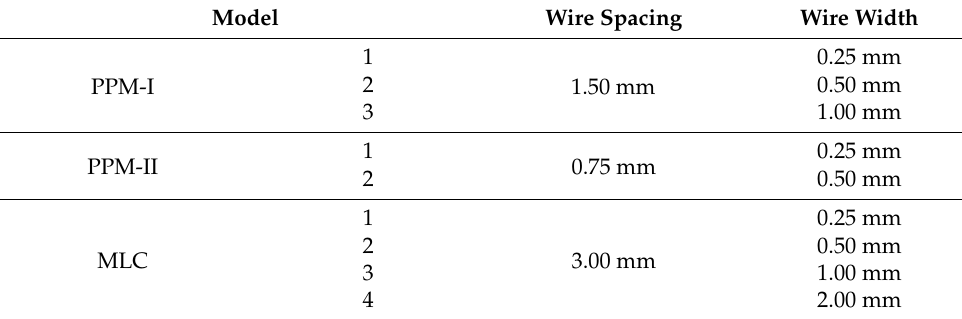
Figure 19. Structure diagram of developed PPM EMATs and conventional MLC EMAT. ( a ) PPM- Ⅰ EMAT, the coil is a racetrack coil with wire spacing of 1.5 mm. ( b ) PPM- Ⅱ EMAT, the coil is a race- track coil with wire spacing of 0.75 mm. ( c ) MLC EMAT, the coil is a meander coil with wire spacing of 3 mm. Table 3. Dimensional parameters of coils in PPM and MLC EMATs. Table 3. Dimensional parameters of coils in PPM and MLC EMATs.